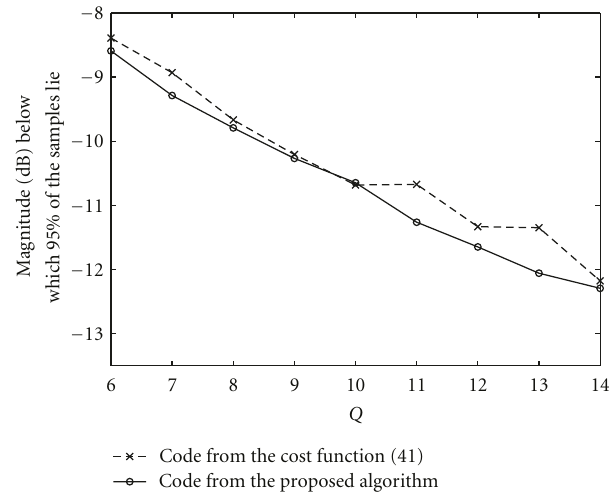
Figure 15: Magnitude of 95th percentile of | Ω ( τ ,0, f , f (cid:6) ) | ( M = 4).